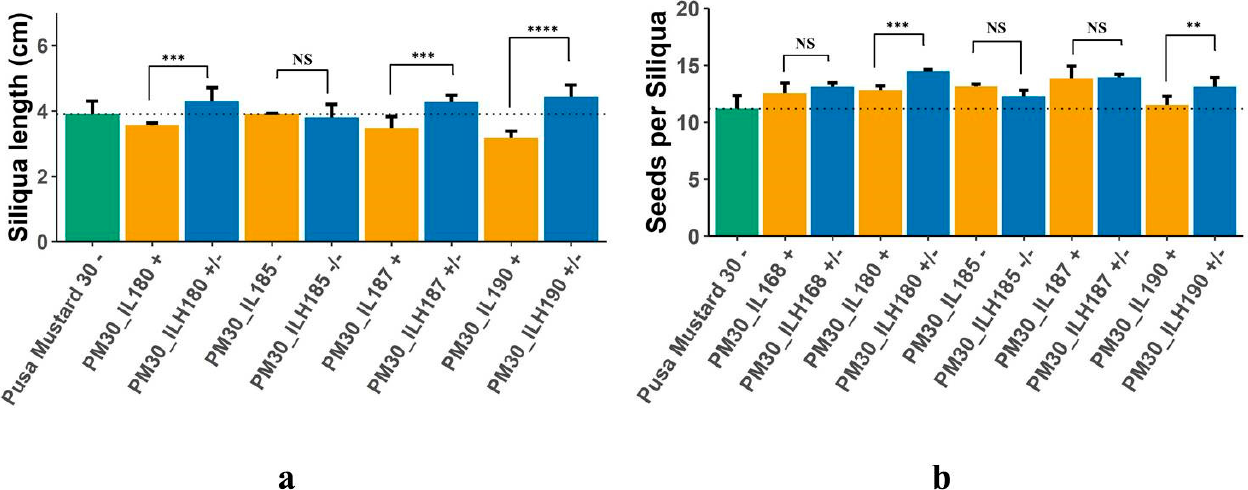
Figure 6. ( a ) Length of siliqua in Pusa Mustard 30, ILs of Pusa Mustard 30, and hybrids derived from them; ( b ) Number of seeds per siliqua in Pusa Mustard 30, ILs of Pusa Mustard 30, and hybrids derived from them (+ sign denote presence of FLA3 gene in homozygous condition,—sign denote absence of FLA3 gene, +/ − sign denote heterozygosity of FLA3 gene; ** significant at p = 0.05; *** significant at p = 0.01; **** significant at p = 0.001; NS = Non Signi fi cant).